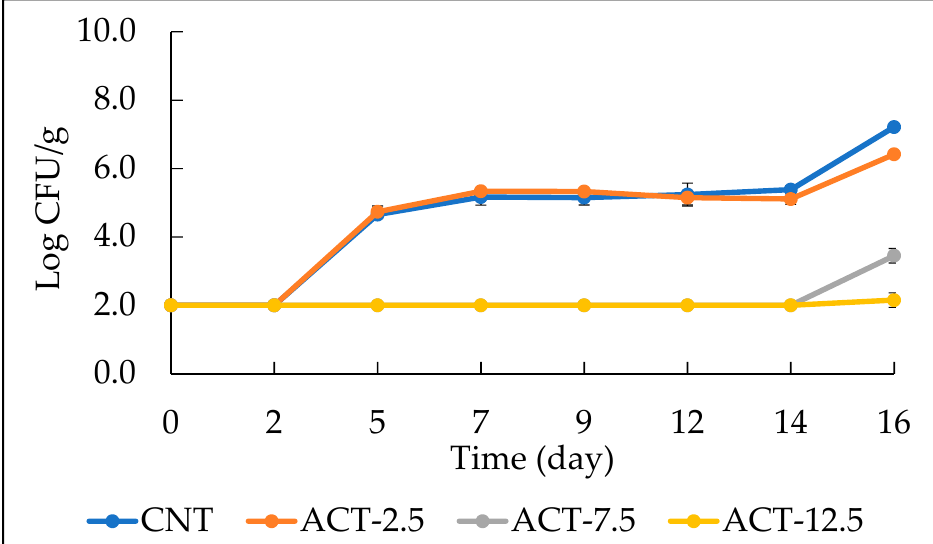
Figure 3. The evolution of psychrotolerant and heat-labile aerobic (PHAB) viable cell concentration in fish burgers during 16 days of storage at 4 °C. Data indicate means ± SD. CNT: fish burger without prickly pear powder; ACT-2.5: fish burger enriched with 2.5 g of prickly pear powder; ACT-7.5: fish burger enriched with 7.5 g of prickly pear powder; ACT-12.5: fish burgers enriched with 12.5 g of prickly pear powder.